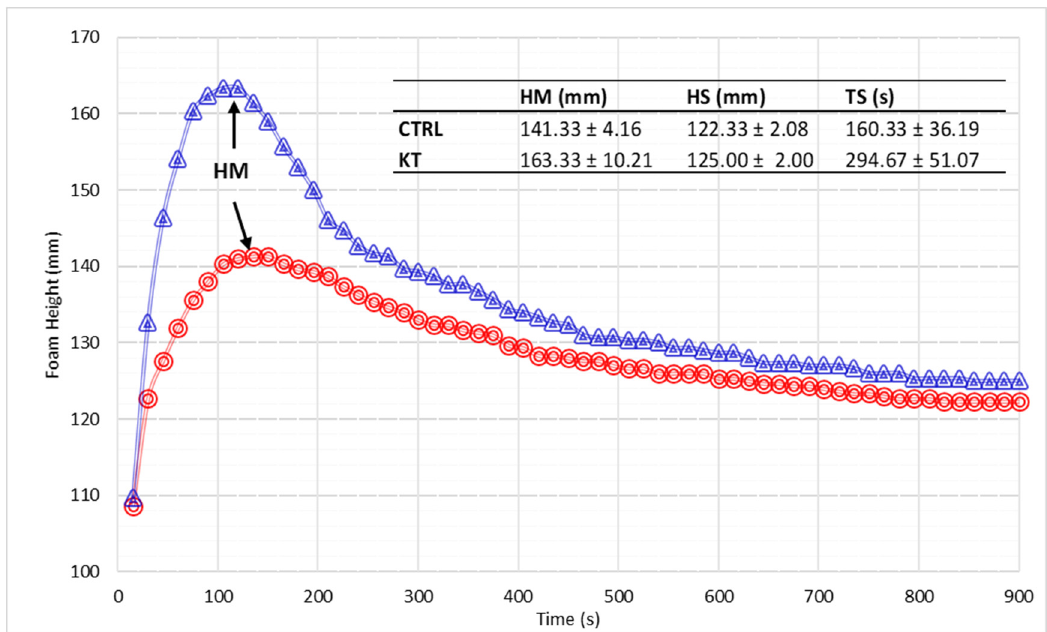
Figure 1. Evolution of the foam height during 15 min of measurement of wine sampled after 12 months of “sur lie” ageing. In the inset are outlined the recorded foam parameters HM = maximum foam height; HS = stability height; TS = stability time. Control (CTRL) ( -O- ) Chitosan (KT) ( - ∆ - ).